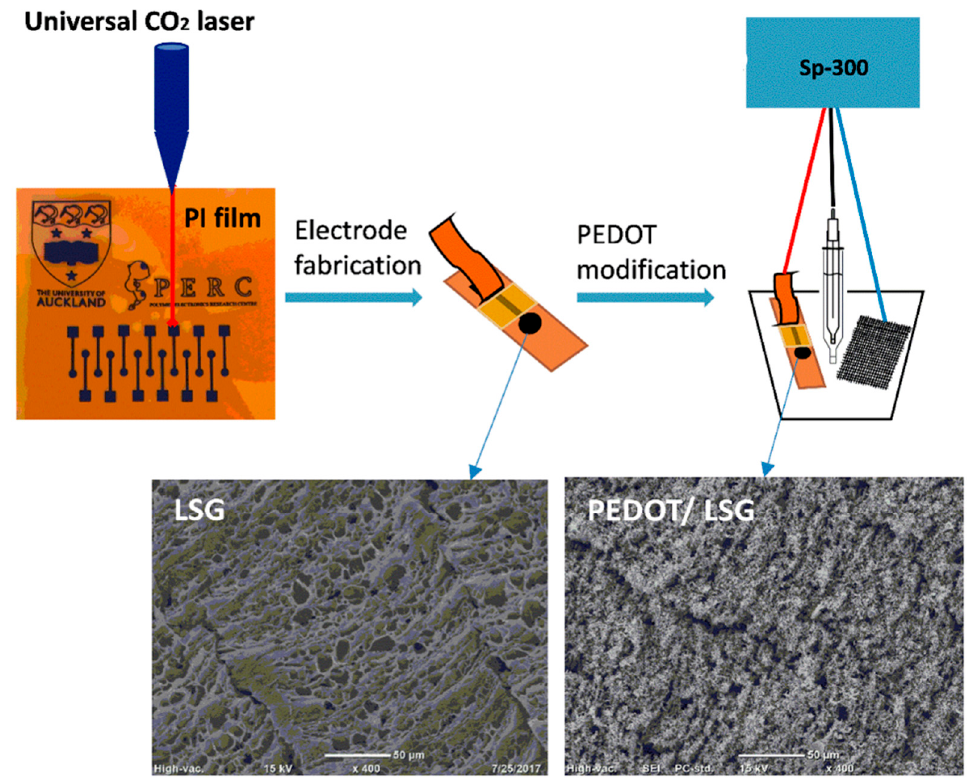
Figure 5. Schematic representation of the fabrication process of PEDOT-Modified Laser Scribed Graphene (PEDOT-LSG) electrodes, and micrographs showing the morphology of LSG and PE- DOT/LSG film. Modified with permission from [112]. Copyright 2018 Elsevier B.V.